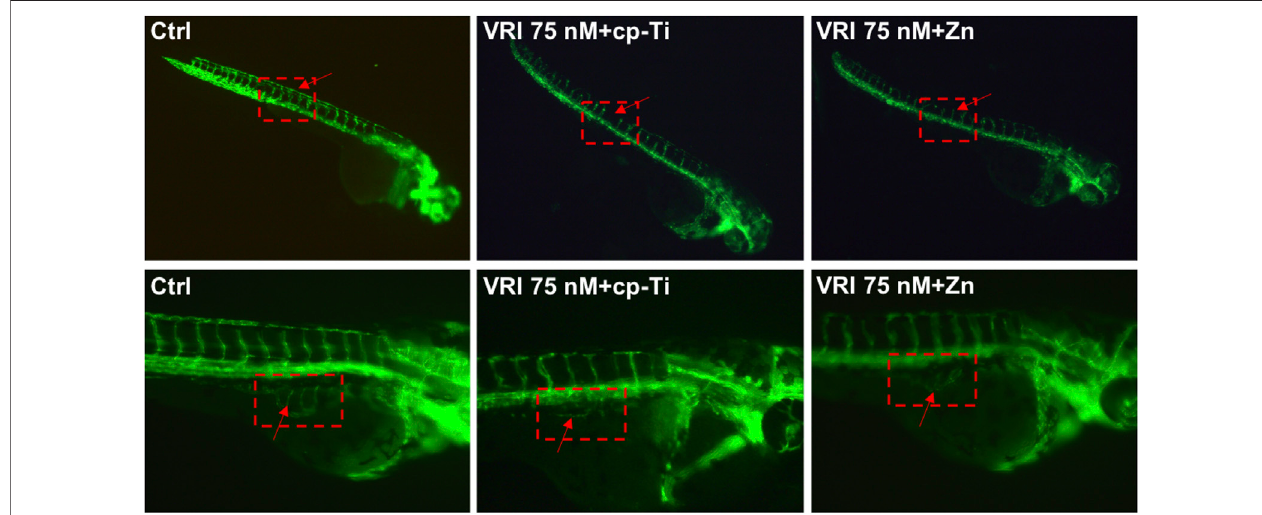
FIGURE 2 | Angiogenesis of transgenic zebra fi sh in the group of control, cp-Ti, and Ti-NW-Zn.